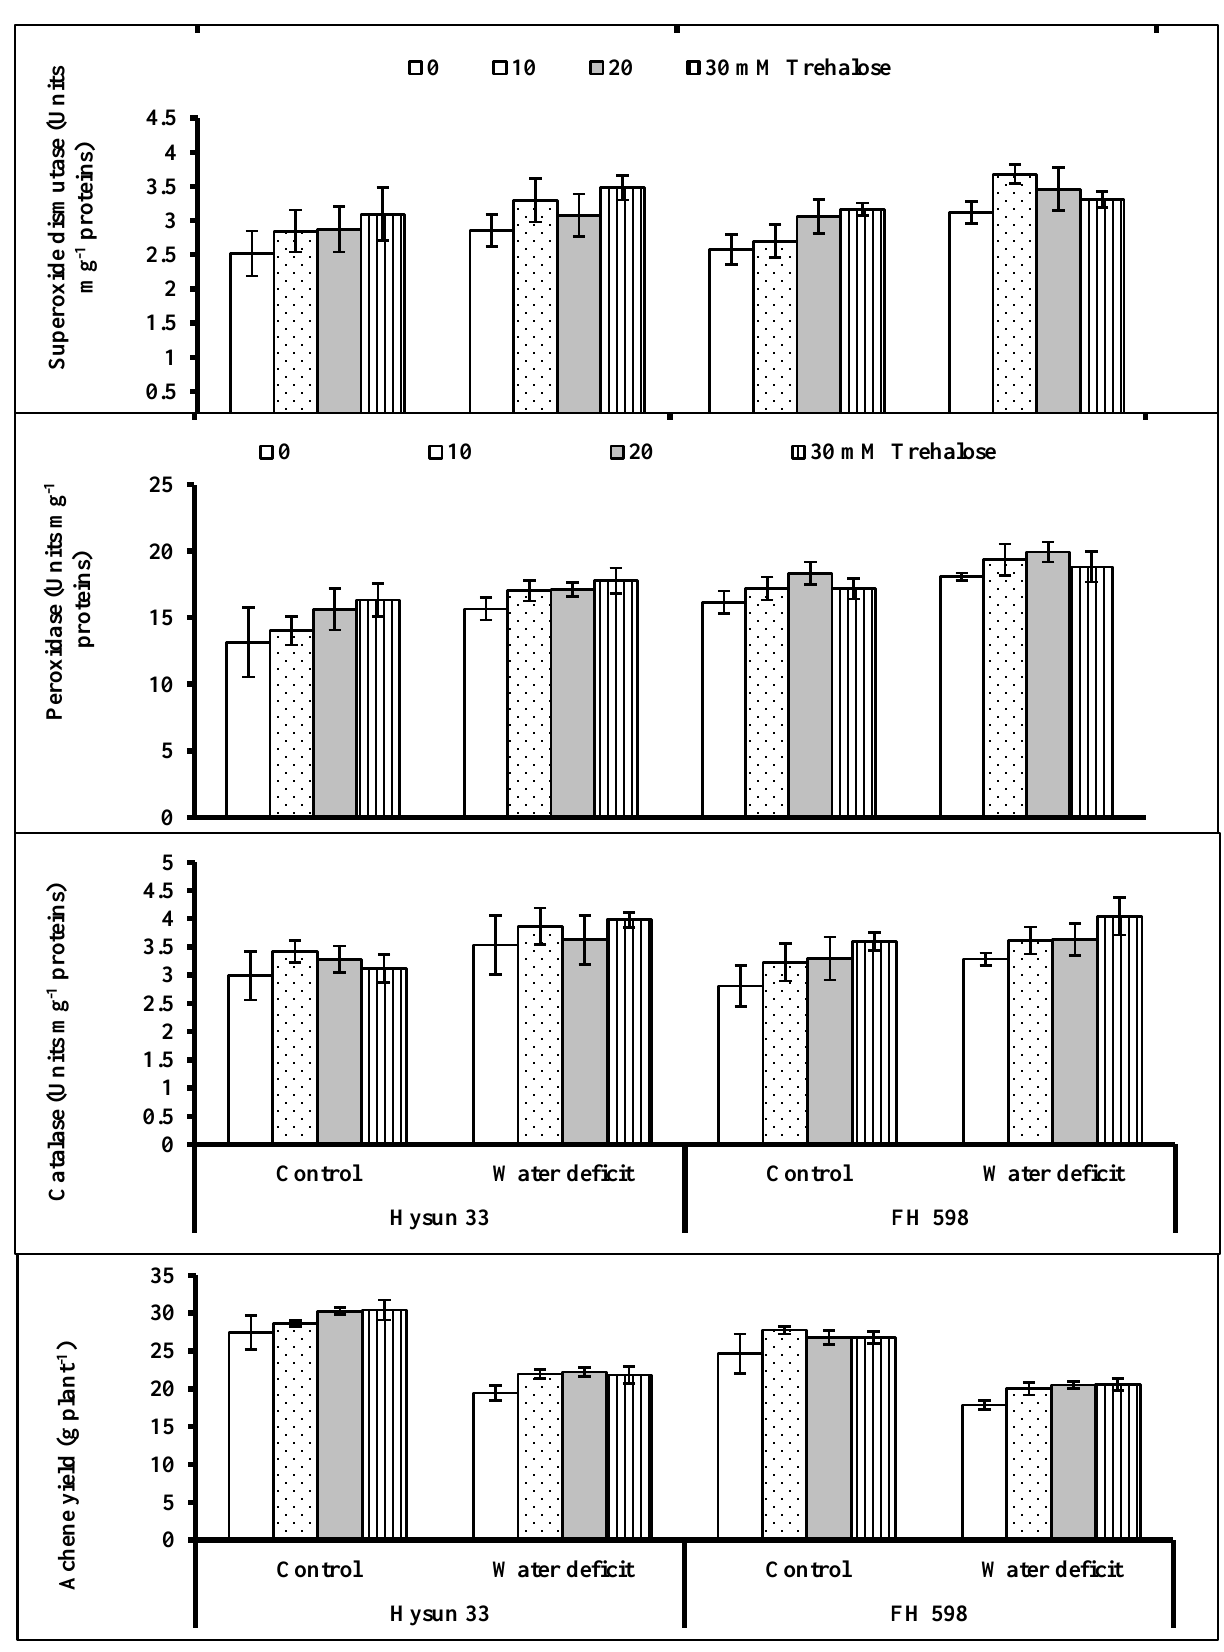
Figure 3. Activities of superoxide dismutase, peroxidase, and catalase enzymes and achene yield per plant for two drought-stressed and non-stressed cultivars of sunflower ( Helianthus annuus L.) plants subjected to varying levels of foliar-applied trehalose (mean ± S.E.).